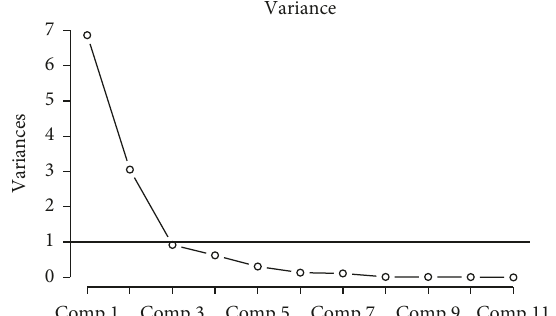
Figure 1: April–September summer regions for 1991–2020.